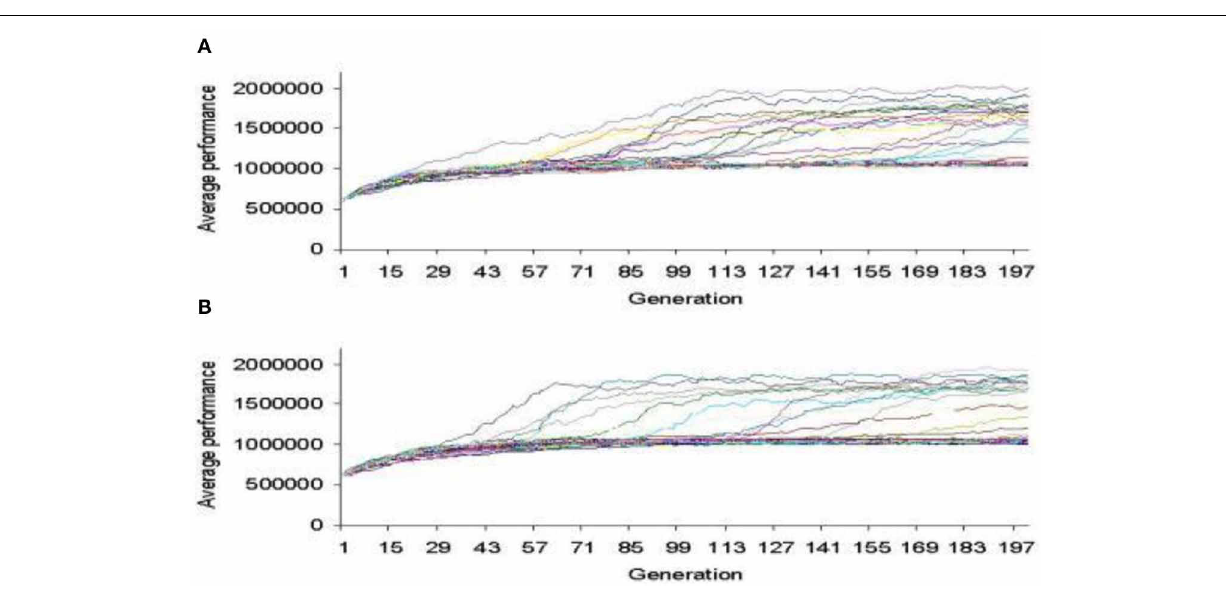
FIGURE 8 | Performance graph where bacterial colonies evolved searching for an optimized AM radio receiver. (A) CORP. (B) COFP (Perales-Graván and Lahoz-Beltra, 2008).